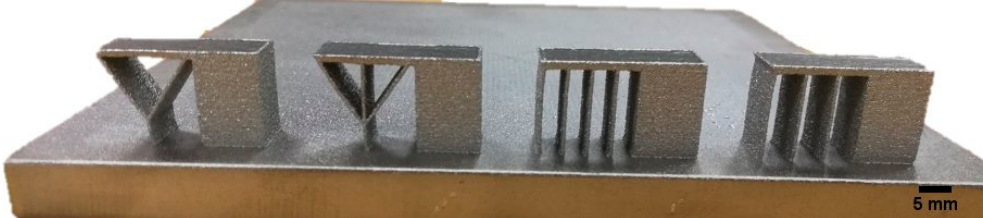
Figure 8. Models with support structures (models B to E) fabricated using EBM.